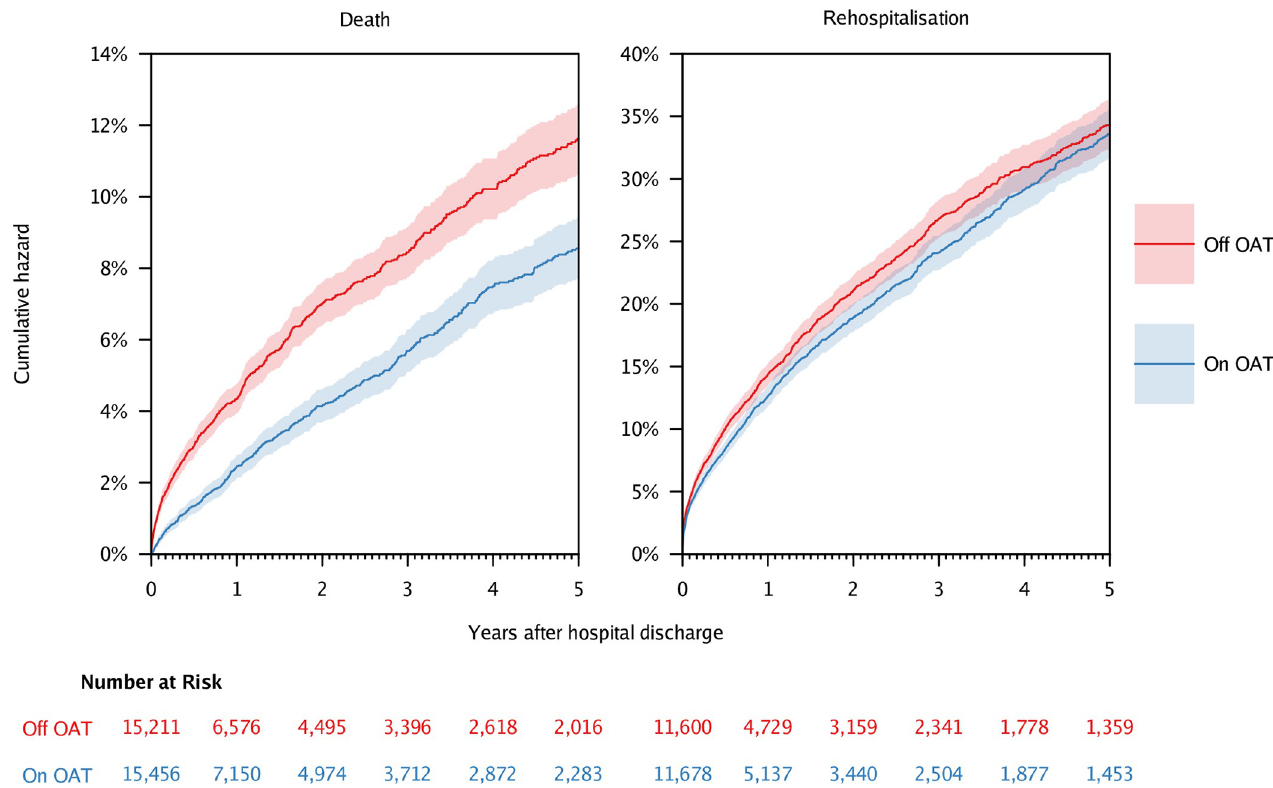
Fig 3. Extended Kaplan–Meier curves for time to death and time to rehospitalization among participants in the OATS study who survived an initial hospitalization with injecting-related bacterial or fungal infection. Both analyses involve 8,943 participants. The death analysis was based on 30,667 treatment or nontreatment periods, and the rehospitalization analysis was based on 23,278 treatment or nontreatment periods. OAT, opioid agonist treatment; OATS, Opioid Agonist Treatment Safety.